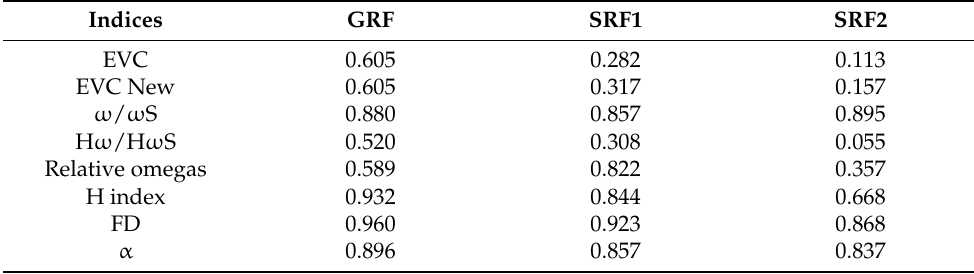
Table 4. Ancillary Bifactor Evaluation